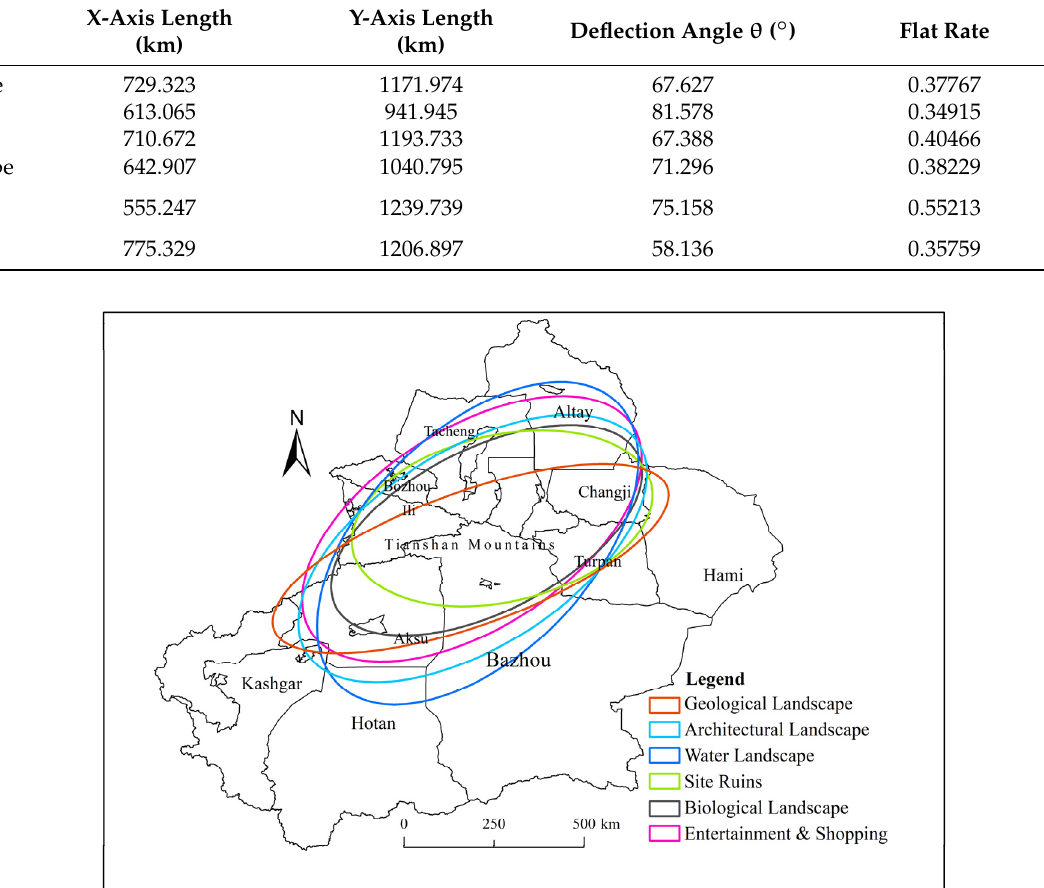
Table 4. Standard deviation ellipse analysis results.